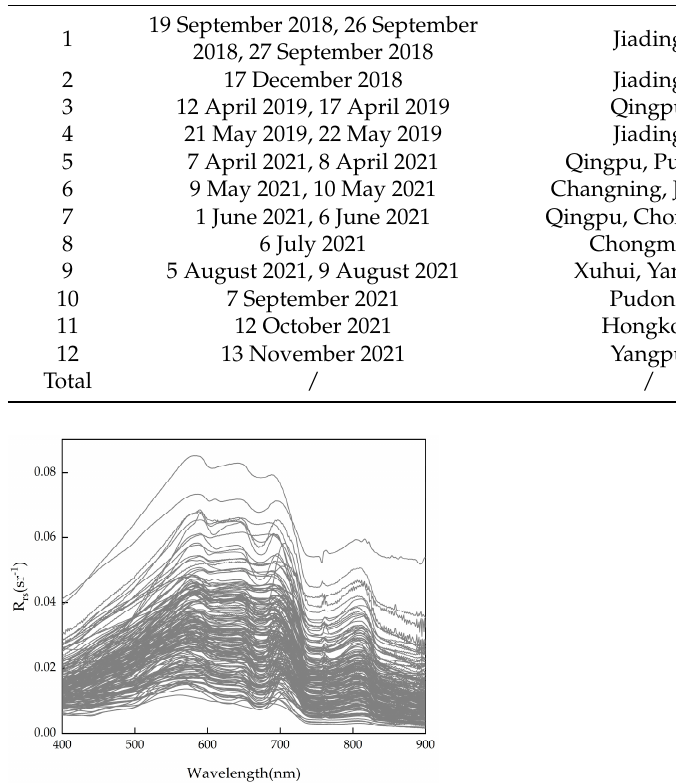
Table 1. Dates, locations, and sample number of each measurement. No.